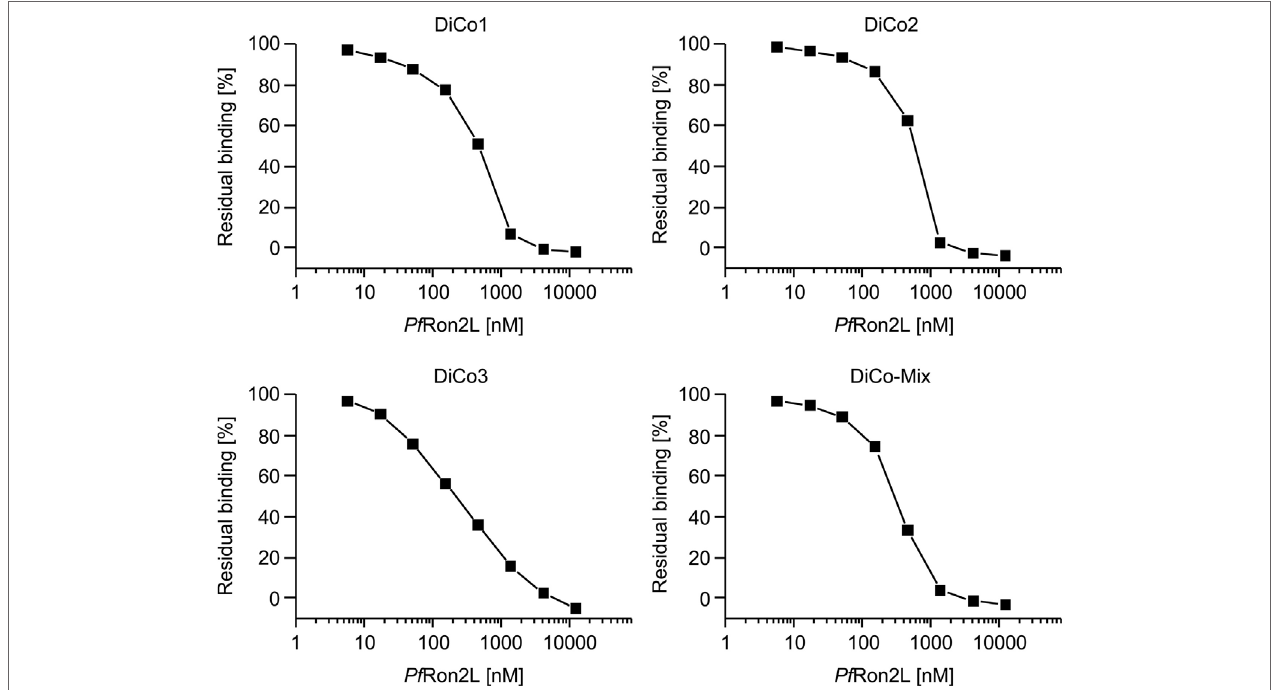
FigUre 1 | Analysis of DiCo– Pf Ron2L complex formation. To determine the equilibrium saturation of the DiCo– Pf Ron2L complex, surface plasmon resonance- based competition experiments were conducted using a biotinylated Pf Ron2L peptide immobilized on a Series S sensor chip streptavidin. Equivalent concentrations of purified DiCo1, DiCo2, DiCo3 as well as a balanced DiCo-Mix were mixed 1:1 with buffer (reference) or decreasing concentrations of the Pf Ron2L peptide. The final concentration in the competition assays was 50 µg/ml for the DiCo proteins with a molecular weight of approximately 62.5 kDa (796 nM) and 50 µg/ml (12,500 nM)— 0.022 µg/ml (5.7 nM) for the Pf Ron2L peptide. The competition samples were incubated for 4 h at room temperature and the residual binding to the immobilized Pf Ron2L was analyzed. The buffer control (reference) was set to 100%, and residual binding was expressed as a percentage compared to the